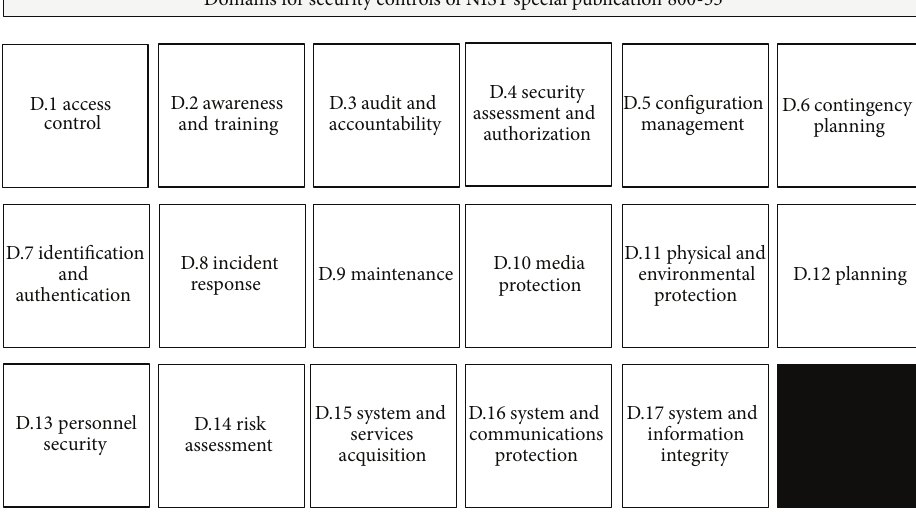
Figure 4: Domains for security controls of NIST SP 800-53.